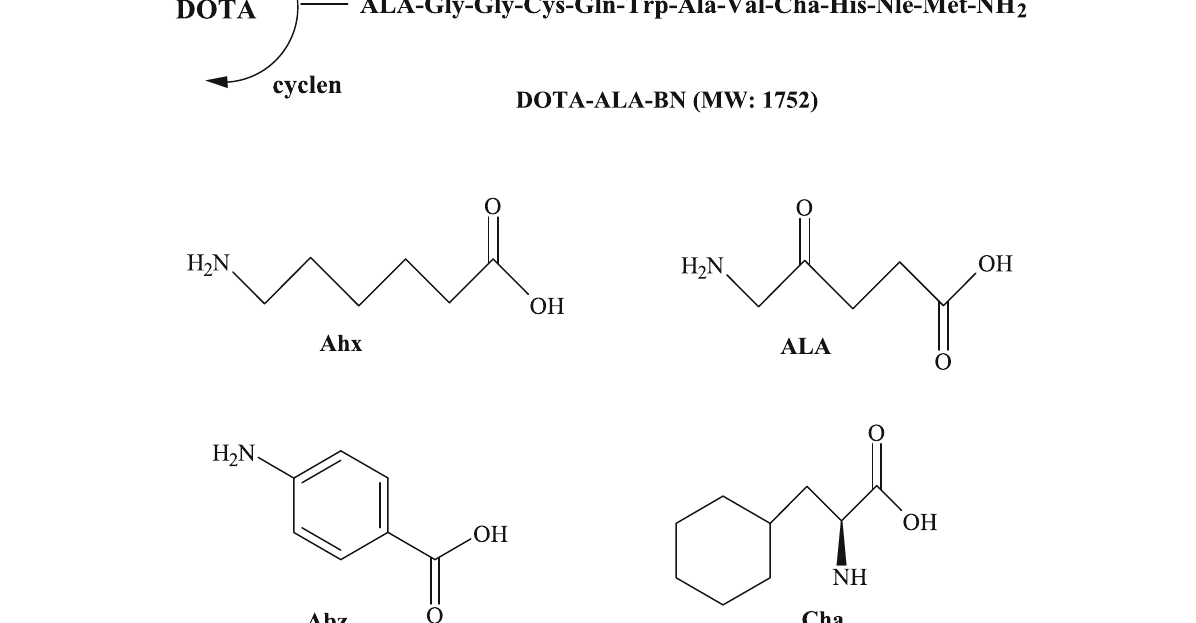
Fig. 3 Structures of the bombesin peptide derivatives prepared by solid-phase peptide synthesis. DOTA was attached to the peptide from cyclen precursor or commercial DOTA-tris- t -Bu ester. Ahx aminohexanoic acid, Abz aminobenzoic acid, ALA aminolevulinic acid, Cha